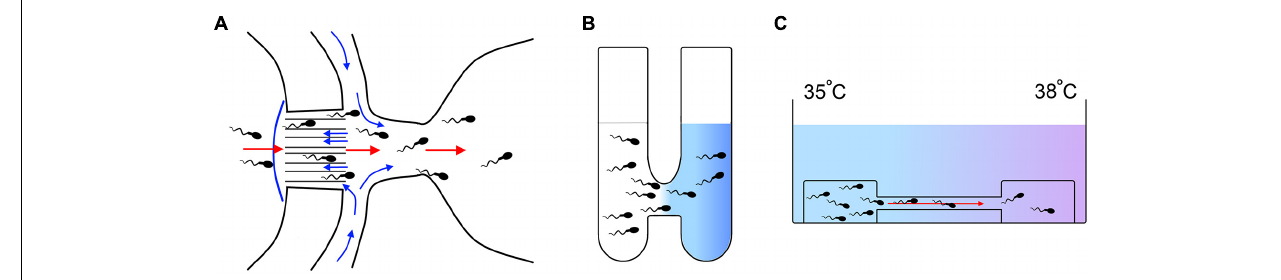
FIGURE 4 | Methods for sperm selection based in guidance mechanisms. (A) Method of sperm selection by rheotaxis developed by Nagata et al. (2018). A flow (blue arrows) is created through a serial of microchannels towards a well were sperm sample is placed. In response to the flow the spermatozoa swim towards it passing through the microchannels and accumulating in a receptive well where they can be collected for downstream applications (red arrows indicate migration of the sperm). (B) Method of sperm selection by chemotaxis developed by Gatica et al. (2013): Two wells are connected by a 2 mm length per 2.5 mm diameter tube. One of the wells is filled with a medium containing the chemoattractant molecule in solution (colored in blue) and the other well is filled with the spermatozoa suspension. The chemoattractant diffuses through the connecting tube generating a gradient and the spermatozoa respond by migrating towards the higher concentration and accumulating in the initial well free of cells where they can be collected for downstream applications. (C) Method of sperm selection by thermotaxis developed by Pérez-Cerezales et al. (2018). Spermatozoa are placed on a drop of a medium connected by a capillary to a second drop free of cells. A temperature gradient is generated between both drops being the highest temperature at the place of the drop free of cells. Spermatozoa respond by thermotaxis migrating towards the warmer temperature and accumulating in the second drop where they can be collected for downstream applications.